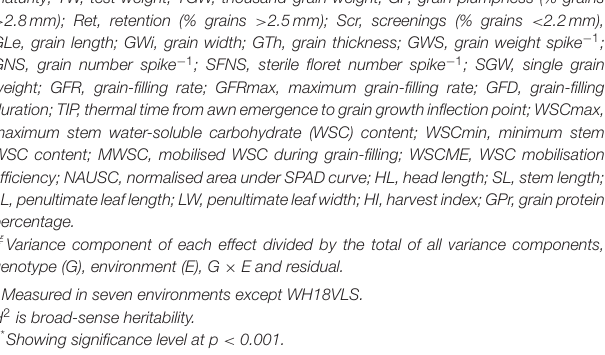
( Supplementary Table S4 ). TGW.HTI, GP.HTI, and